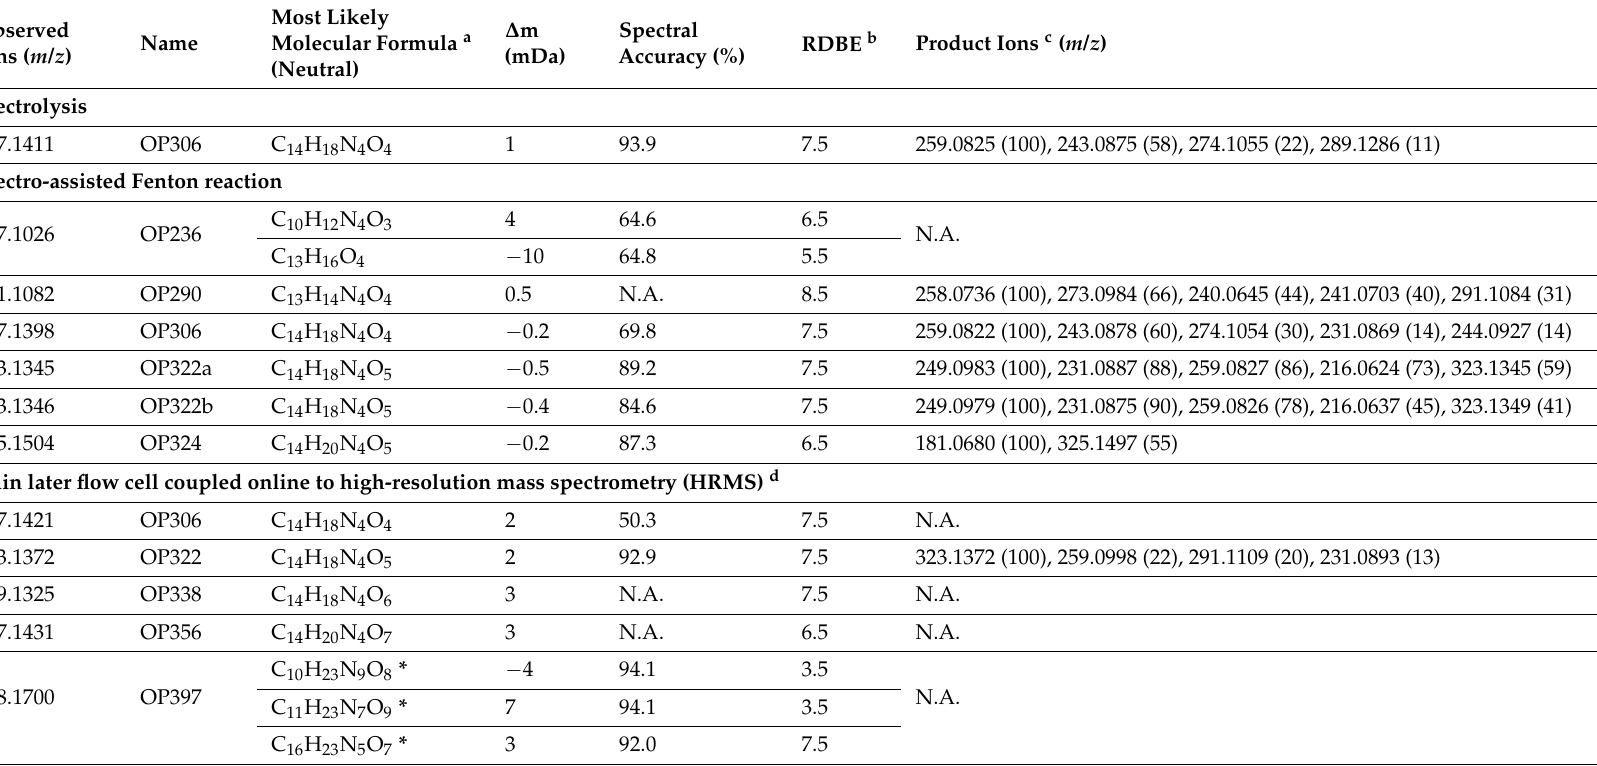
Table 1. Proposed molecular formulas and major product ions of the precursor ions observed in the electrochemistry